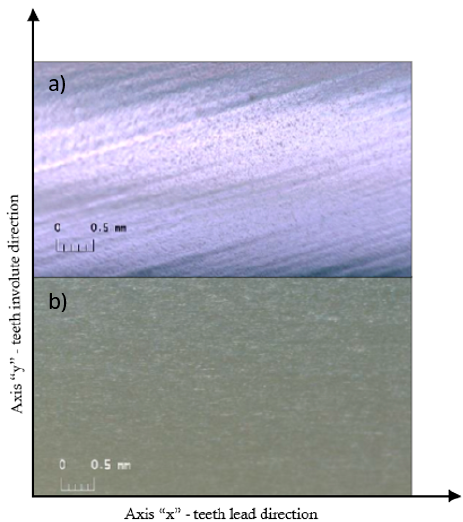
Figure 8. Gear tooth flanks visualization before ( a ) and after ( b ) abrasive process parameters opti- mization.